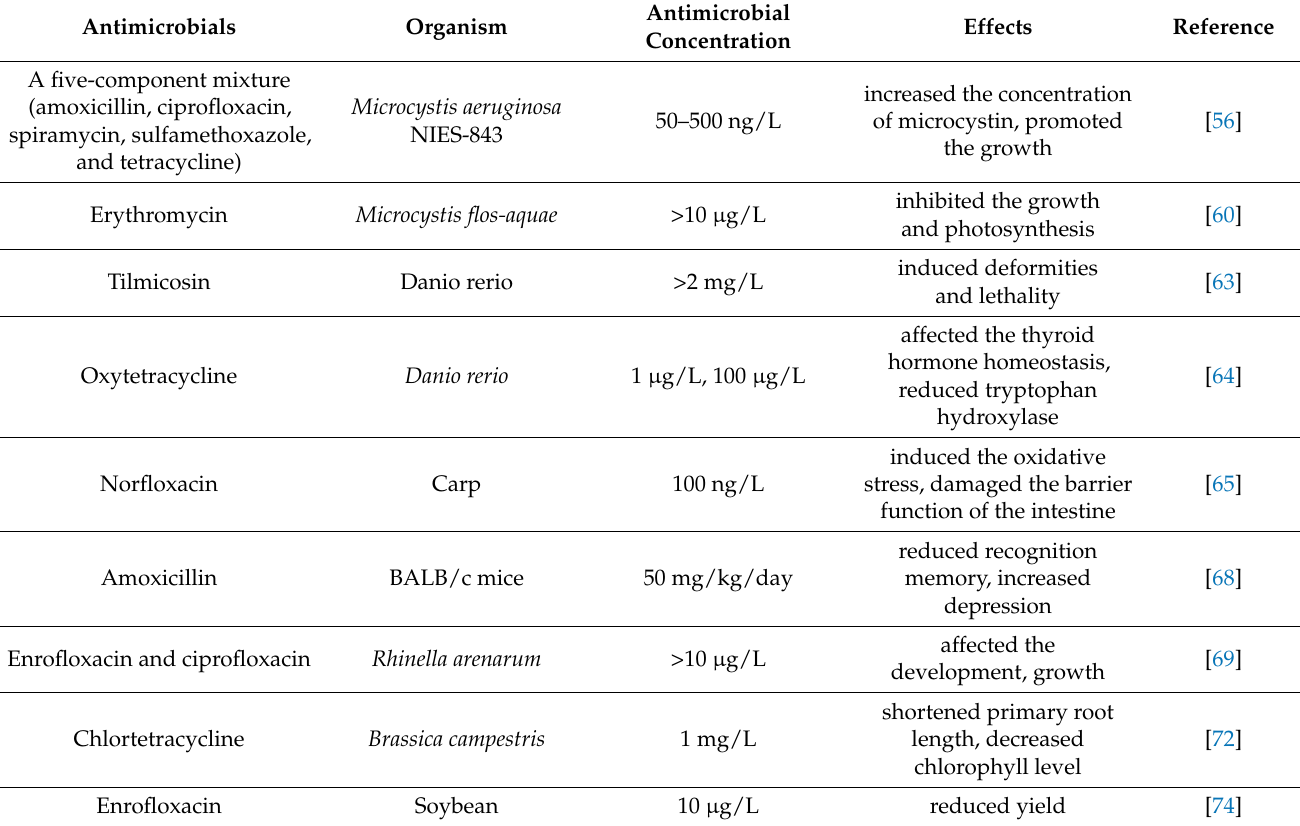
Table 1. The effects of antimicrobials on organisms in an